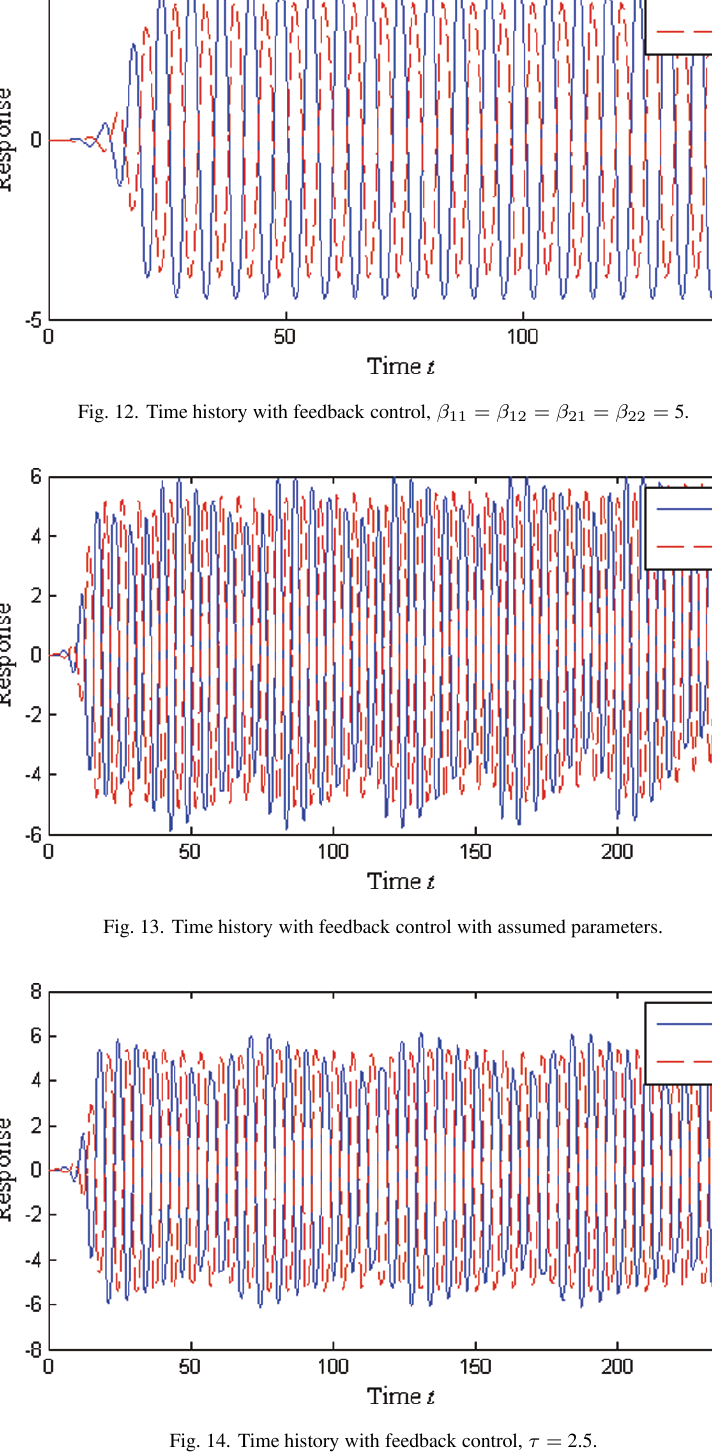
Fig. 14. Time history with feedback control, τ =